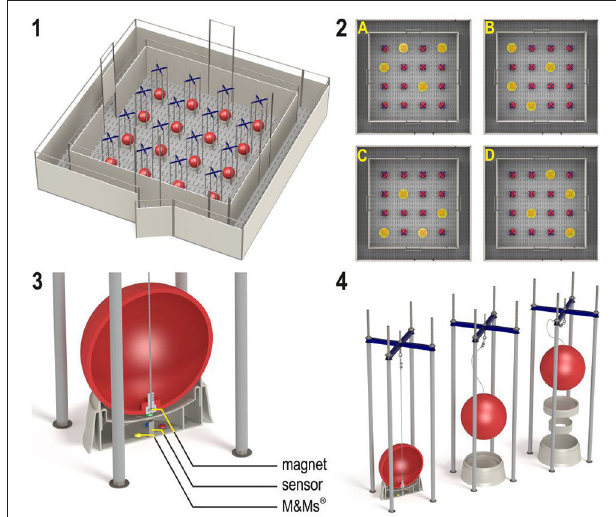
FIGURE 1 | (1) The spatial cognitive holeboard for pigs. (2) The four patterns of baited holes. (3), (4) Constructional details of the holes. Each hole—a fool bowl with a false bottom under which three M&M’s® chocolates are placed in order to mask odor cues—is covered by a red ball. Each food bowl is equipped with a sensor that sends a signal to the computer if the contact with the magnet in the ball is interrupted; i.e., when the pig lifts the ball with its snout (illustrations: Yorrit van der